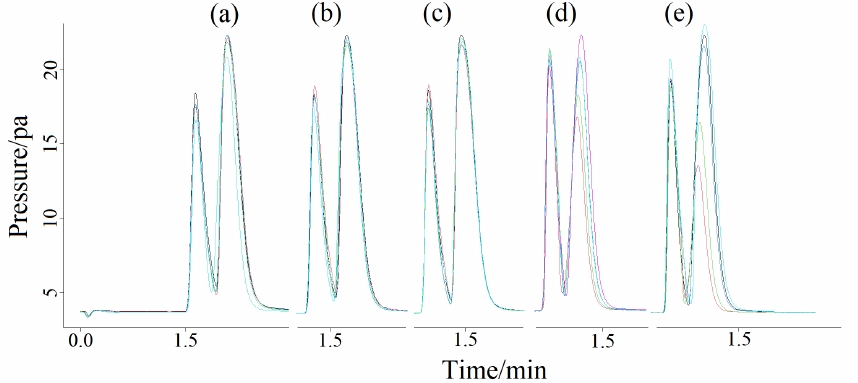
Figure 1. Ghost peaks of methane at different column chamber temperatures ( a – e ) from 60 to 100 °C (10 °C/interval, 5 repetitions per sample) based on manual splitless mode. Peak at column chamber temperature of 60 ( a ), 70 ( b ), 80 ( c ), 90 ( d ) and 100 °C ( e ), respectively.